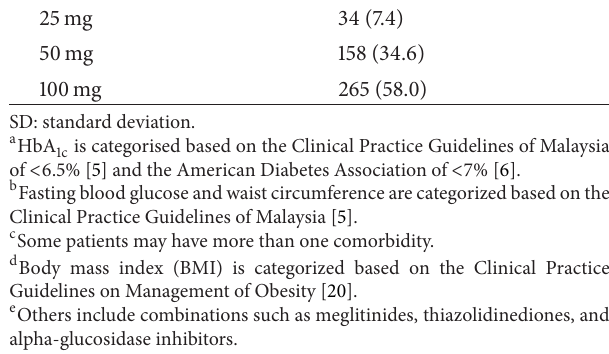
Figure 2: HbA 1 levels at all three measurement points ( 𝑁 = 244 ); c o: outlier; ∗ : extreme case; STG: sitagliptin; mths: